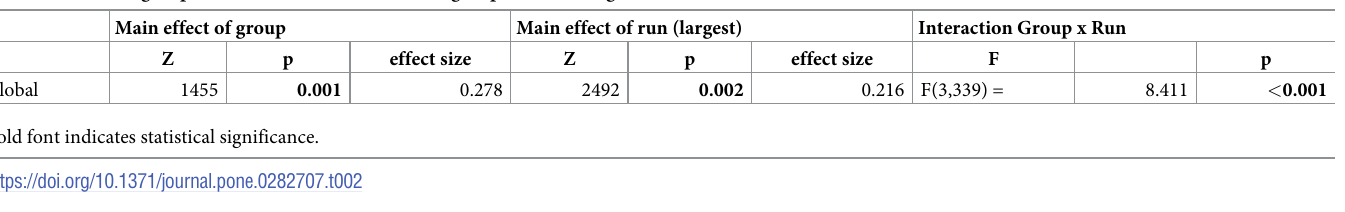
Table 2. Effects of group, run, and interactions between group and run, on global VAR.